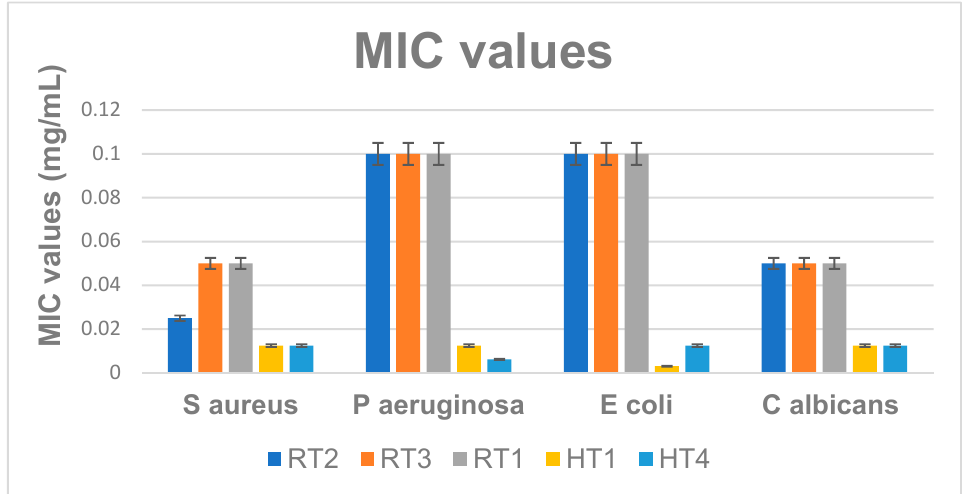
Figure 15. Graphic representation of the MIC values (mg/mL) for the evaluated samples Obtained after 24 h of incubation of microbial strains in the presence of the obtained NPs, p < 0.05 when comparing MICs of RT samples to MICs of HT samples.